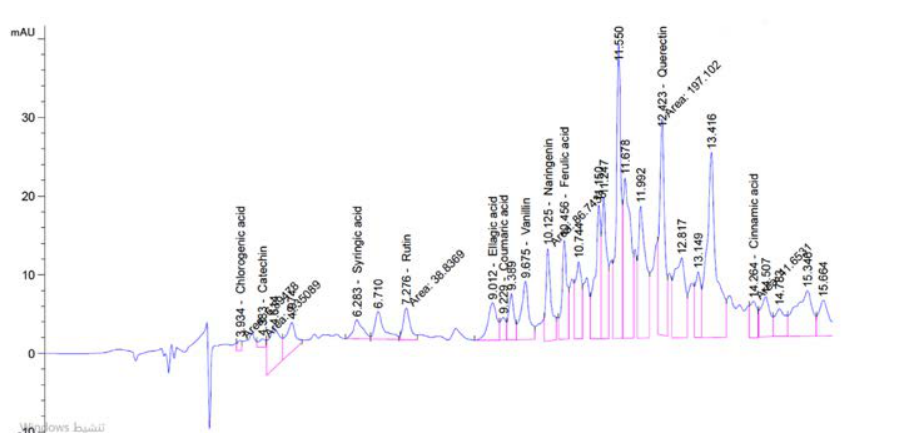
Fig. 2. Commiphora myrrh resin ethyl acetate extract (Conc. 15 mg/ml)